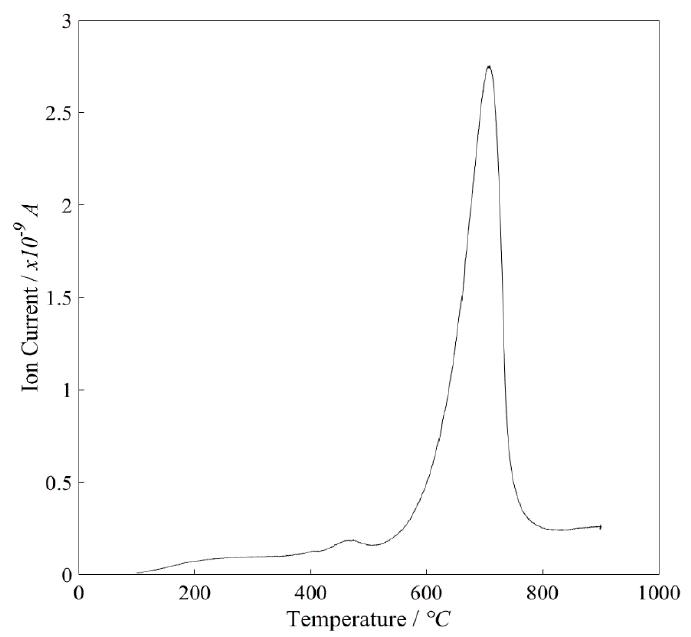
Figure 11. Temperature programmed oxidation showing the CO 2 mass spectrometry trace against temperature of the Thermogravimetric Analysis (TGA) for a sample of coked combined particles composed of CaO and Ni (21 wt % Ni) post Sorption Enhanced Steam Reforming (SESR) but prior to calcination and burn off.